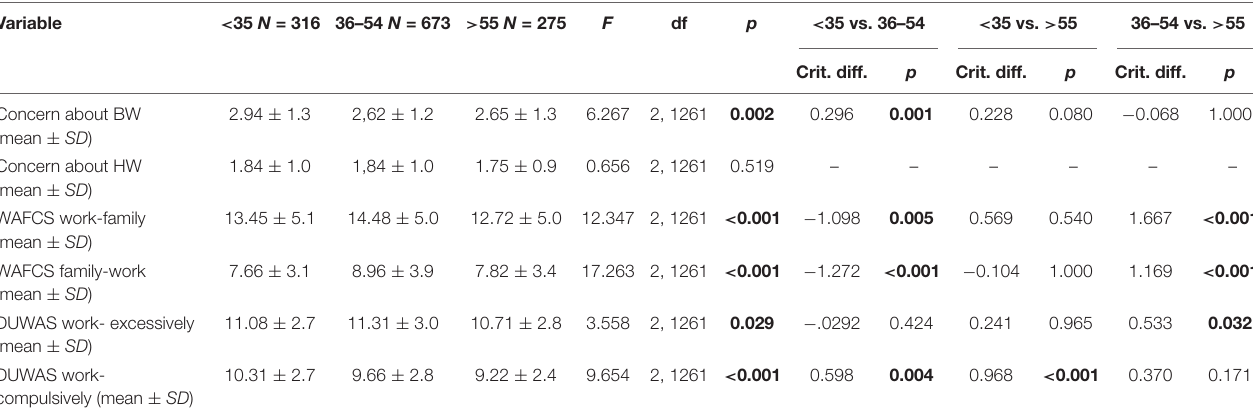
TABLE 3 | Questionnaires scores in the Reopening group by age class.